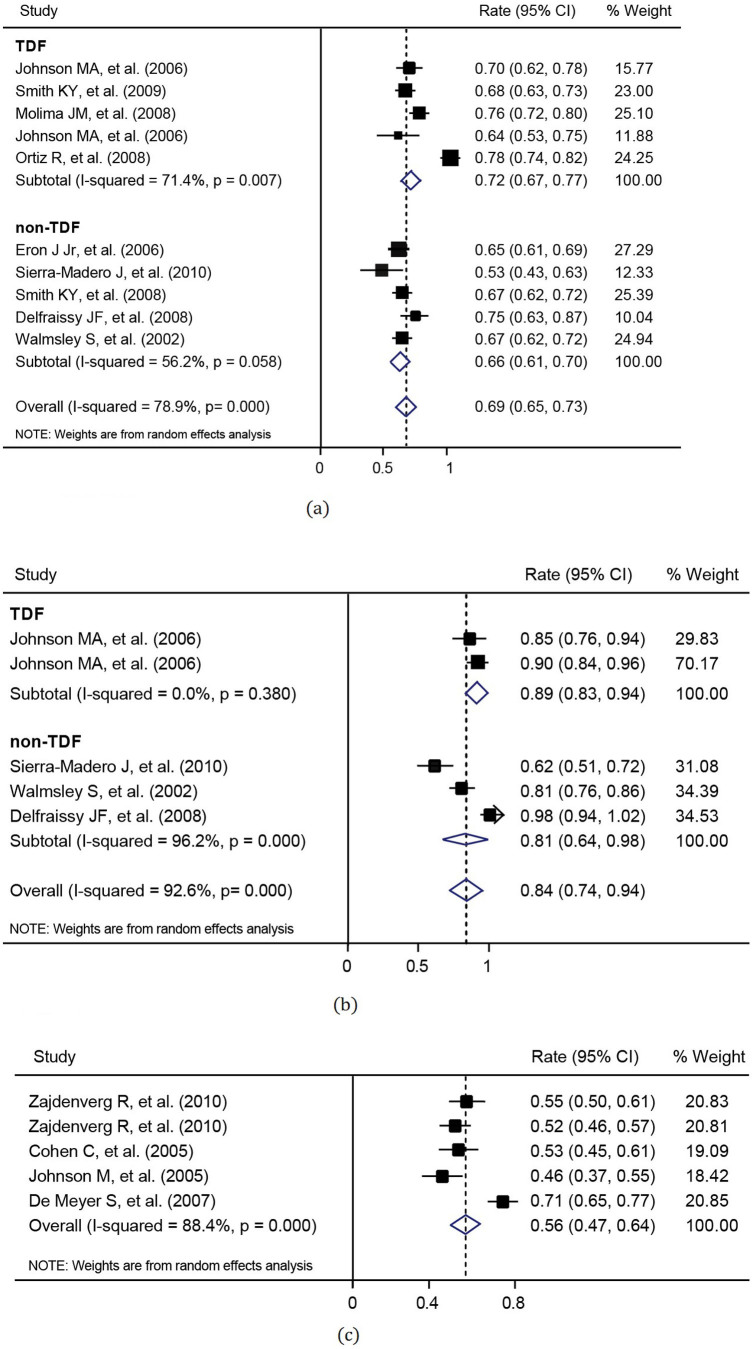
Meta-analysis of virologic response rates for ART-naïve patients under (a) intention-to-treat analysis (heterogeneity: I2 = 78.9% and p < 0.001; publication bias: p = 0.721); and (b) pre-protocal analysis (heterogeneity: I2 = 92.6% and p < 0.001; publication bias: p = 0.221).